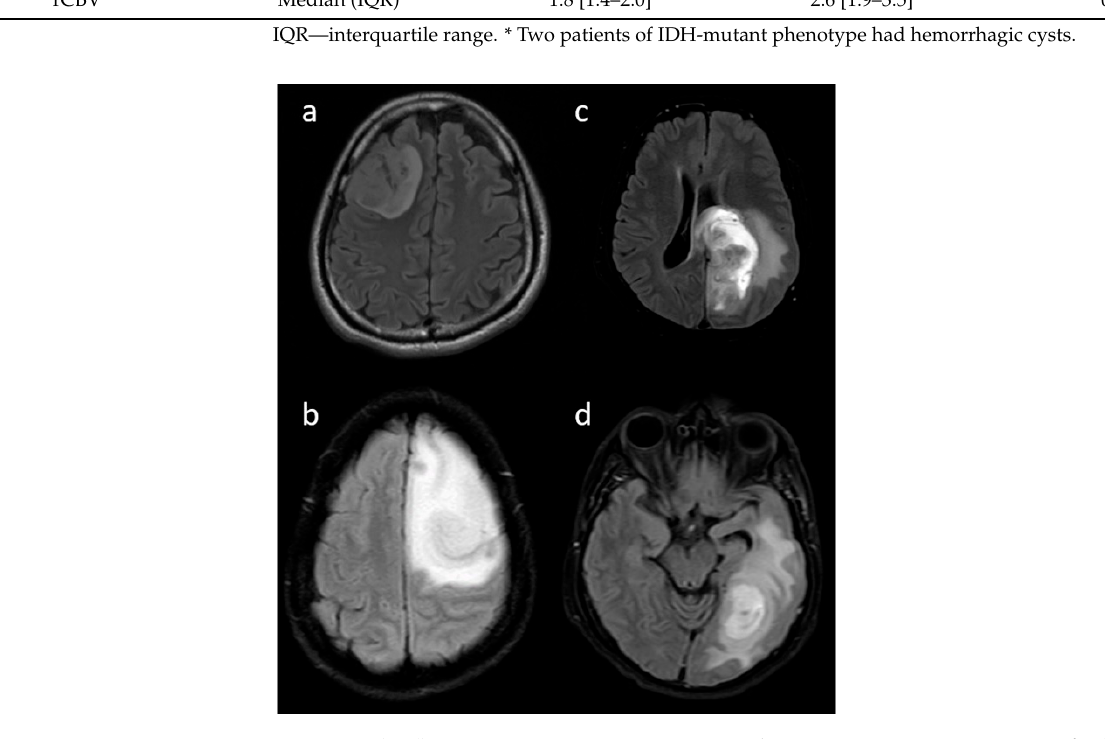
Figure 4. ( a – d ) Axial T1w, T2w, FLAIR, and post-contrast T1w images reveal a peritumoral cyst adjacent to the primary tumor. Additional ( e , f ) sagittal T2w and sagittal T1w are also shown.